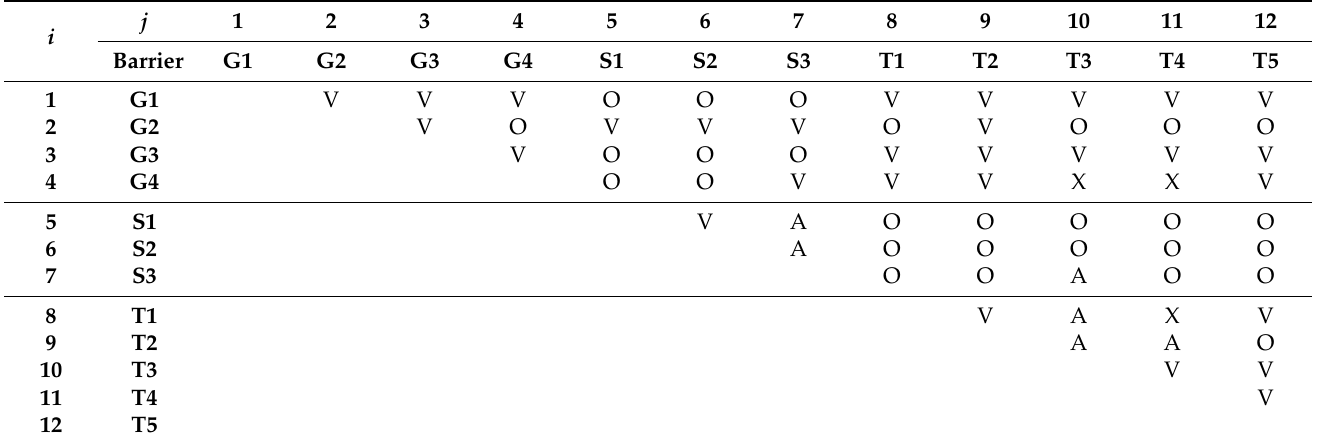
Table A1. Structural Self-Interaction Matrix (SSIM) (Conventional